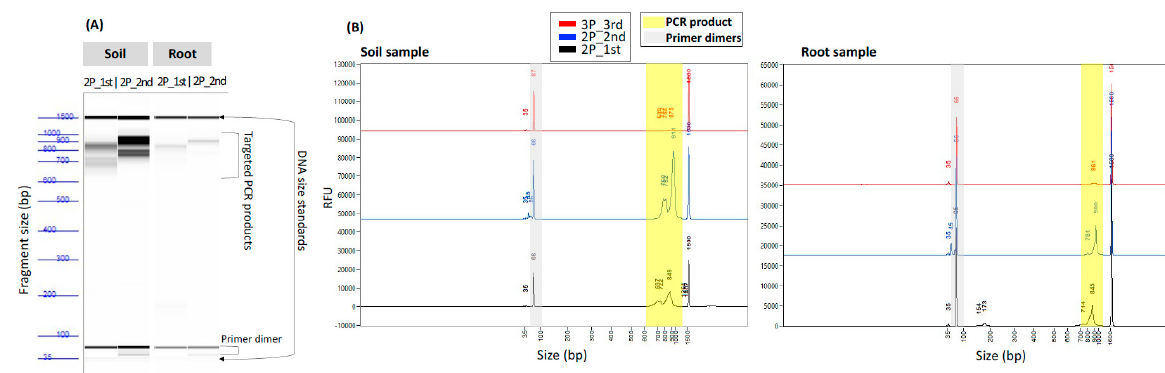
Figure 4. PCR product lengths detected by Fragment Analyzer ™ measurements. PCR libraries were prepared with two-step (2P) and three-step (3P) protocols from the same DNA extractions (one soil and one root). PCR was performed with a fungus-specific primer set ITS1F and ITS4 (dataset 1). PCR products resulting from each of the three PCR steps of protocol 3P are referred to as 3P_1st, 3P_2nd, and 3P_3rd (Table 2). Similarly, the PCR steps of protocol 2P are referred to as 2P_1st and 2P_2nd (Table 2 and Figure 2). ( A ) Simulated gel image with DNA fragments shown as black bands. The Y-axis corresponds to the size of the fragment. The DNA fragments for both the soil and root samples demonstrated an increase in PCR product size from 2P_1st to 2P_2nd. Bands at 35 and 1500 bp are size standards; bands at ca. 66 bp are primer dimers. ( B ) An overlay of the DNA size spectrums generated from each PCR step using a soil and a root sample. The X-axis indicates the size of the DNA fragment measured. The Y-axis corresponds to the intensity of the Relative Fluorescence Unit (RFU) viewed as a proxy for fragment abundance at the given size. The root sample yielded PCR products with peaks at 845 bp (2P_1st), 900 bp (2P_2nd), and 861 bp (3P_3rd product). The PCR product of a soil sample yielded PCR product size peaks such as 849 bp (2P_1st), 911 bp (2P_2nd), and 875 bp (3P_3rd). The DNA standards of 35 and 1500 bp are shown. 2P = two-step PCR protocol; 3P = three-step PCR